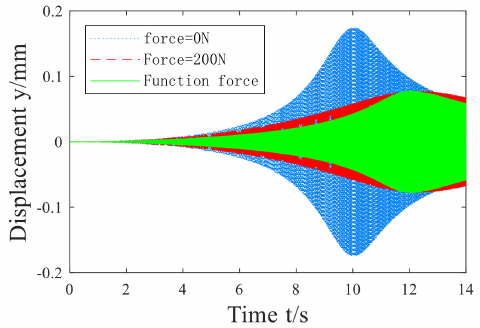
Figure 24. Response curves of the shaft system under di ff erent control methods.